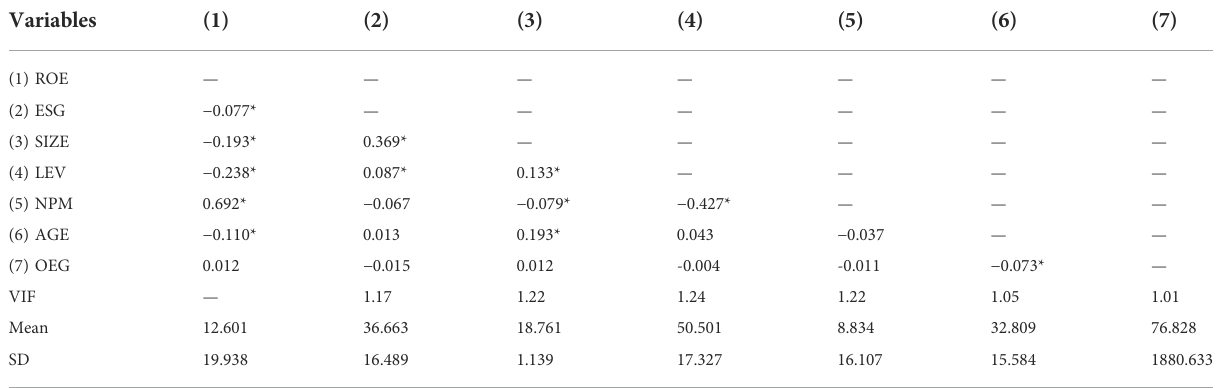
TABLE 1 Descriptive statistics and correlation matrix of main variables.